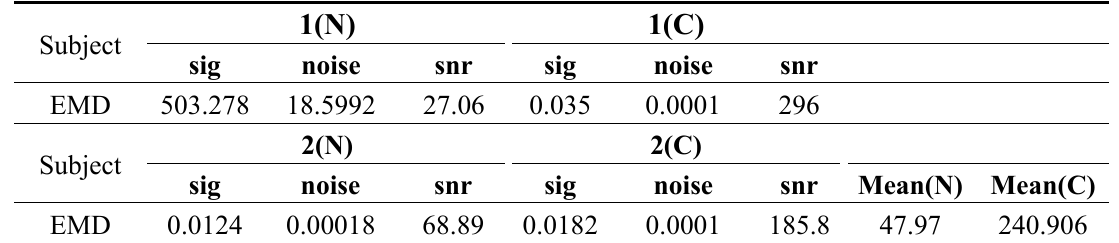
Table 2. Dry electrode comparison. Normal environment (N) and an anechoic chamber(C). Mean value for n = 2.